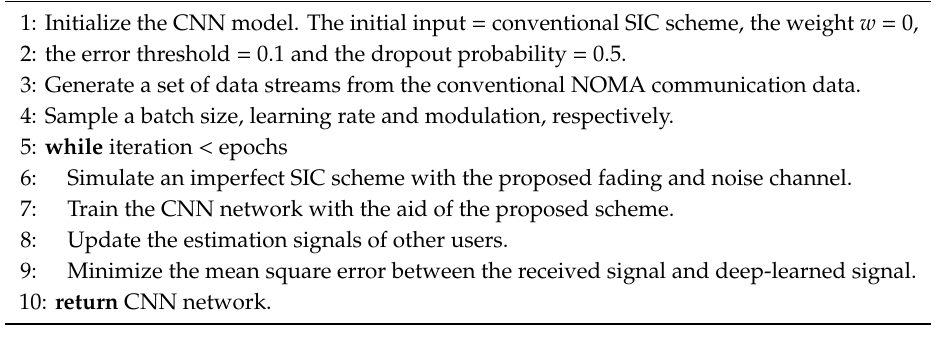
Algorithm 1. CNN-Based SIC Training Process Algorithm